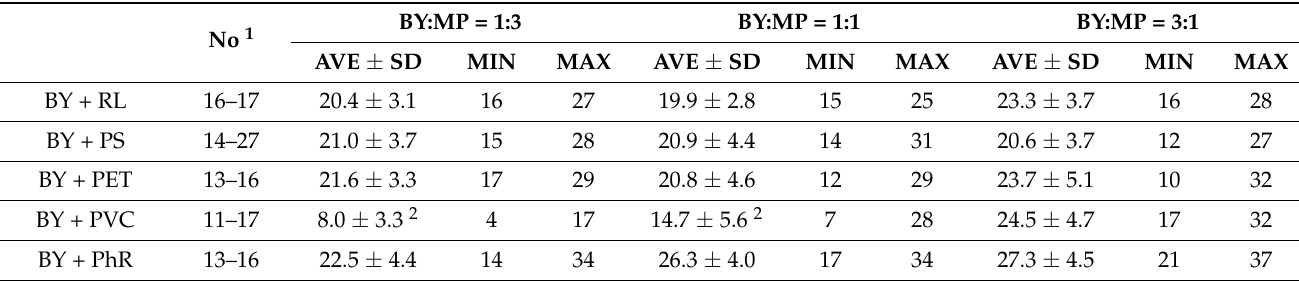
Table 3. Number of vacuoles formed by the protozoan S. ambiguum after 24 h in binary MP + BY mixtures having different proportions of